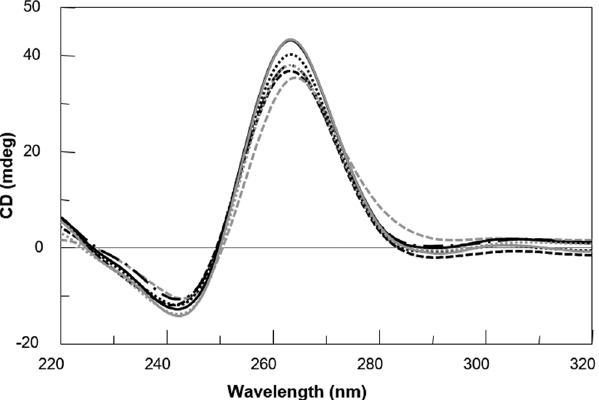
Figure 3. CD spectra of the ODNs investigated. Conditions: 20 °C in potassium phosphate buffer (1 mM KH 2 PO 4 /K 2 HPO 4 , 3 mM KCl, pH 7.0) at 35 µ M ODN strand concentration. INTB - nat (black dashed line), TT - INTB - nat (grey dashed line), INTB - H2 (black dashed dotted line), INTB - H5 (black solid line), INTB - H9 (black dotted line), INTB - H13 (grey dotted line) and INT - BH17 (grey solid line).